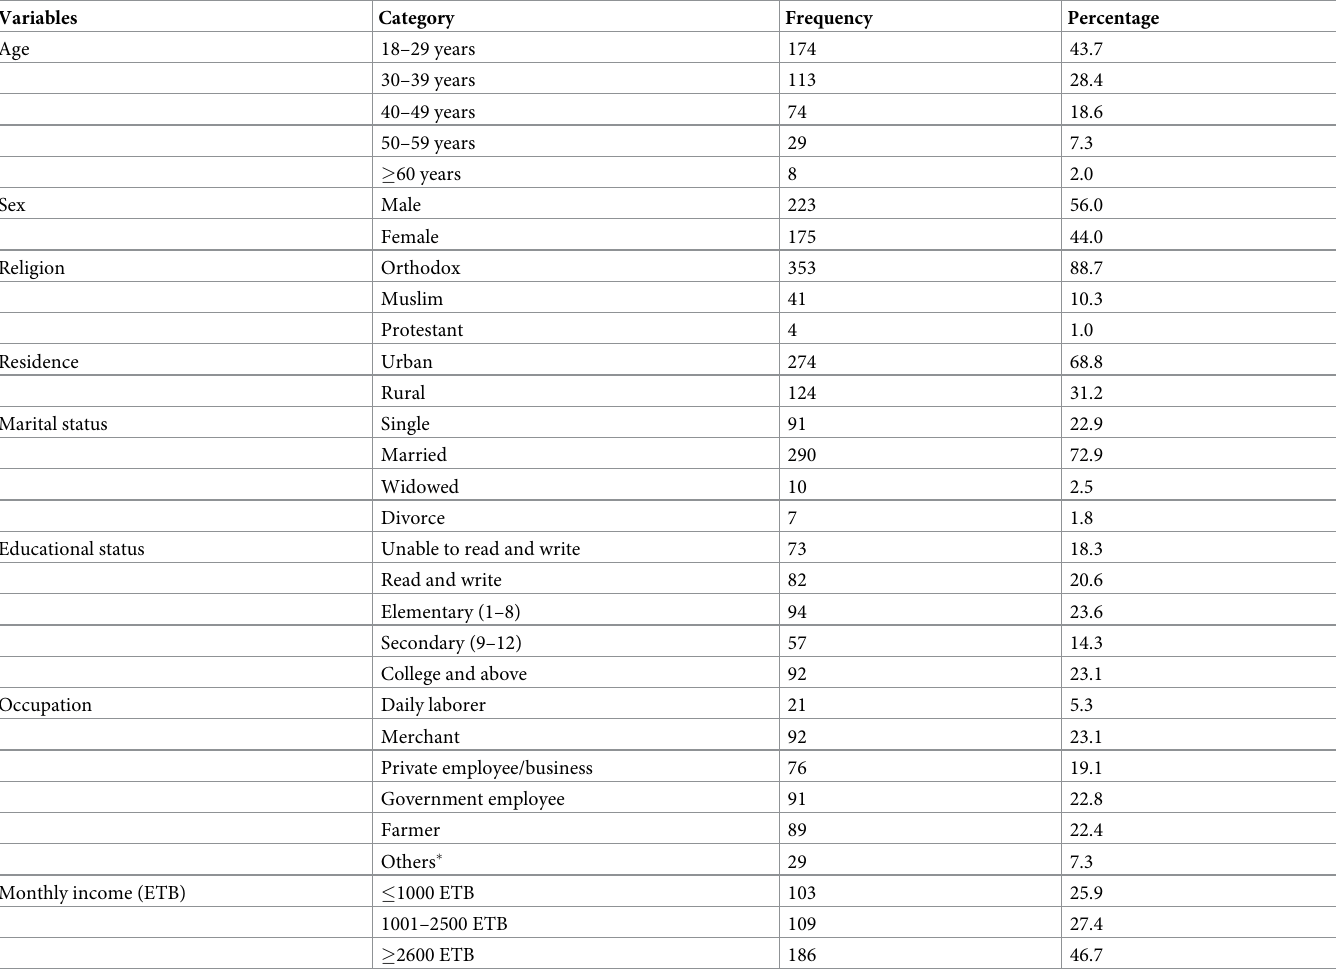
Table 1. Socio-demographic characteristics of the outpatient service visitors in Debre Markos compressive specialized hospital, Amhara region, Ethiopia, 2020. Variables